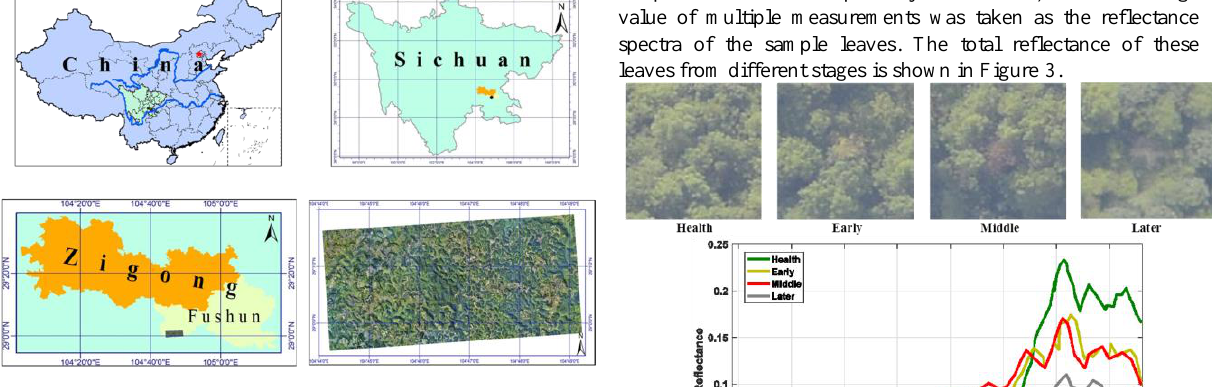
Figure 1. Location Map of experimental site